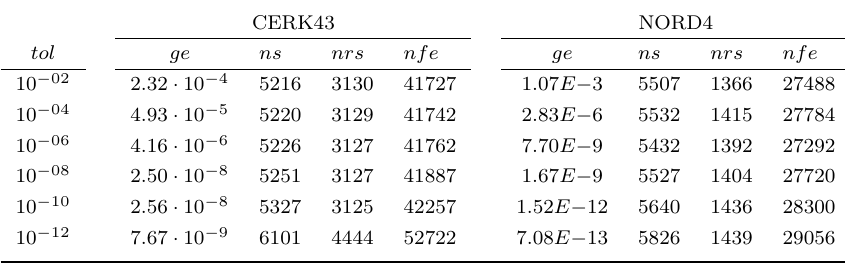
Table 8. Numerical comparison of CERK43 and NORD4 methods applied on the Van der Pohl oscillator (4.3), with standard stepsize control CERK43